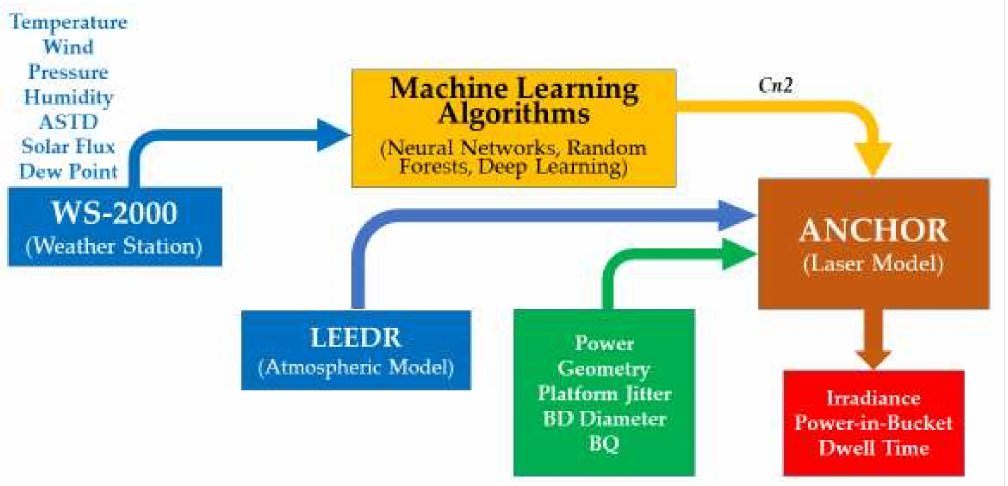
Figure 5. The improved ML-based NPS laser performance code scheme.